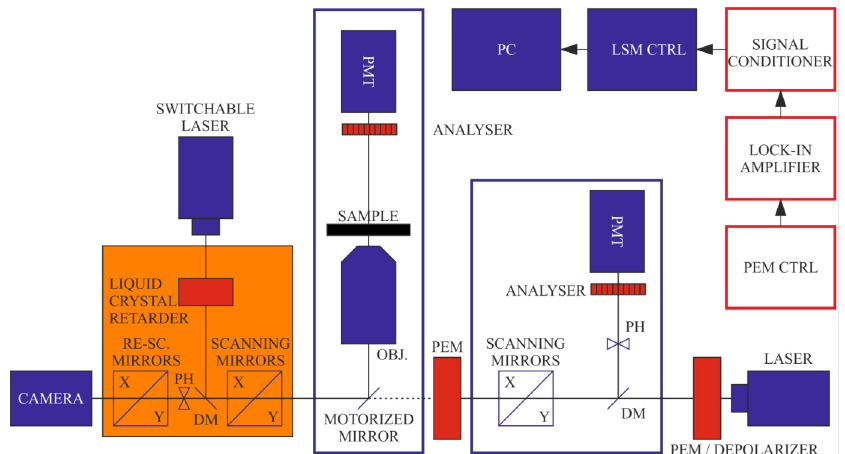
Figure 1. Schematics of the combined set-up of DP-LSM and DP-RCM, using a common platform of an inverted fluorescence microscope. Units of the ‘conventional’ LSM and RCM are displayed in blue and orange colours, respectively; red boxes are the components of the DP